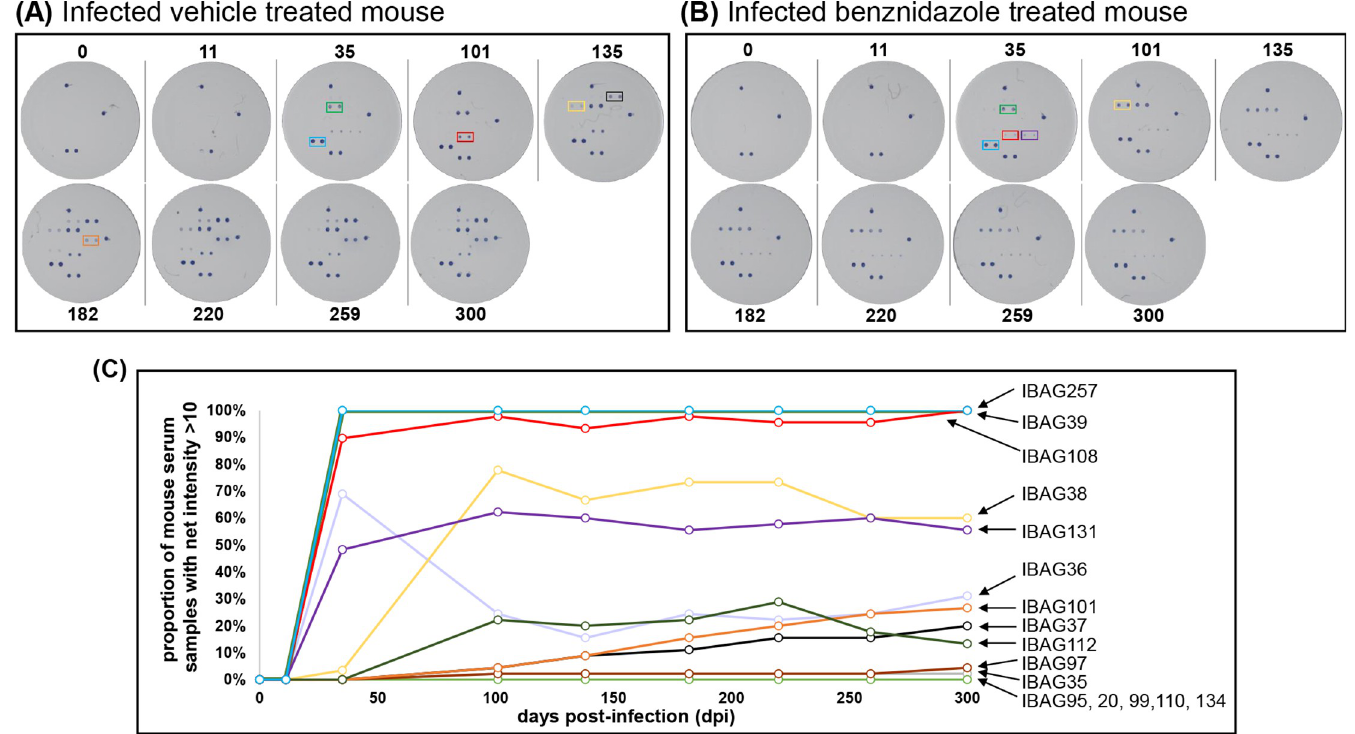
Fig 2. Multiplex immunoassay antigen screening with serum from benznidazole treated and non-treated T . cruzi infected mice. (A) Images of multiplex assays screened with serum from a vehicle treated infected BALB/c mouse (BN201-4). (B) Images after screening with serum from an infected mouse (BN206-4) that had been subjected to benznidazole treatment (100 mg kg -1 , 5 days), initiated 101 days post-infection (dpi). The dpi are indicated. Antigens were arrayed in duplicate as in Fig 1. For illustrative purposes, specific antigens are framed as follows: IBAG39 (green), IBAG257 (blue), IBAG108 (red), IBAG37 (black), IBAG38 (yellow), IBAG101 (orange), IBAG131 (purple). (C) Longitudinal data showing the proportion of serum samples reacting with selected antigens at a net intensity > 10 (minimum set threshold) at each time point (n = 45). Each IBAG is indicated by an arrow. The curves of the two most reactive antigens IBAG257 (blue) and IBAG39 (green) overlap.